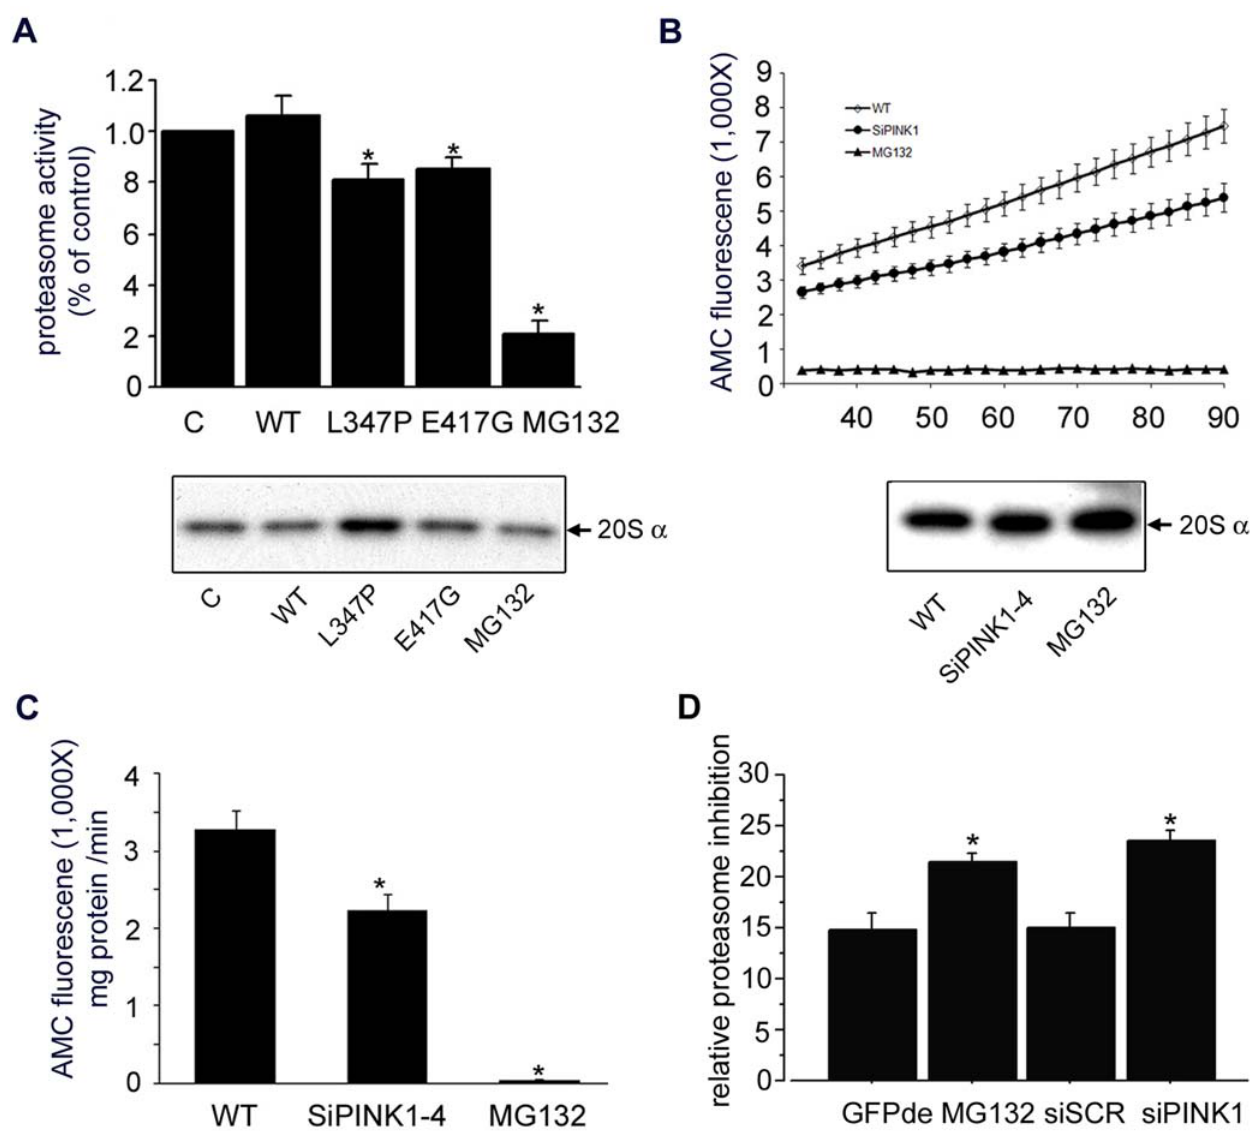
Figure 8. Proteasome function is impaired by mutant or loss of PINK1. Proteasome activity was measured from SH-SY5Y cells expressing mutant PINK1 (A), and PC12 cells expressing siRNA against PINK1 (B, C, D). A) Fluorescence of fluorogenic proteasome substrate Suc-LLVY-AMC (Calbiochem) is positively correlated with proteasome function. No statistically significant changes were detected in proteasome activity between control SH-SY5Y cells and the cells expressing wild type PINK1 (n=8, p=0.484, paired student t test). There was a statistically significant decrease of proteasome activity in the SH-SY5Y cells expressing L347P-PINK1 (23% reduction, n=7, p=0.018, paired student t test) or in SH-SY5Y cells expressing E417G-PINK1 (19.4% reduction, n=8, p=0.012, paired student t test) compared to cells expressing wild type PINK1. MG132, a proteasome inhibitor, was used as a negative control. The bottom panel is a Western analysis of the above samples with the 20S a subunit Ab for normalization. B) Proteasome activity was measured in 20 m g of cell lysate isolated from wild type control PC12 cells (open diamond) or SiPINK1-4 PC12 cell line (filled circle) for 60 min after 30 min incubation. Wild type PC12 cells lysate treated with MG132 (filled triangle) was used as a negative control. The result revealed that the kinetic of proteasome activity monitored over 60 min was markedly decreased in the cells with reduced PINK1. The bottom panel is a Western analysis of the above samples with the 20S a subunit antibody for normalization. C) Histographic presentation for Figure 7B. The reduction of PINK1 by siRNA impairs the proteasome activity (31.8% reduction, n=8, p=0.01, ANOVA). Experiments were repeated with SiPINK1-2 PC12 cell line, and consistent results were obtained (data not shown). D) PINK1 mediated proteasome activity deficit confirmed by another independent method in the HeLa cells. Compared to control (CFP-de transfection), siRNA against PINK1 (siPINK1) knocked down PINK1 and led to a sigfinicant inhibition of CFP degradation (p=0.0001, ANOVA) to an extent similar to direct proteasome inhibition by MG132 (p=0.0014, ANOVA). A scrambled siRNA (siSCR) had no effect (p=0.876, ANOVA). The RNAi sequences are: GAGAGGUCCAAGCAACUA TT and CCUGGUCGACUACCCUGAU